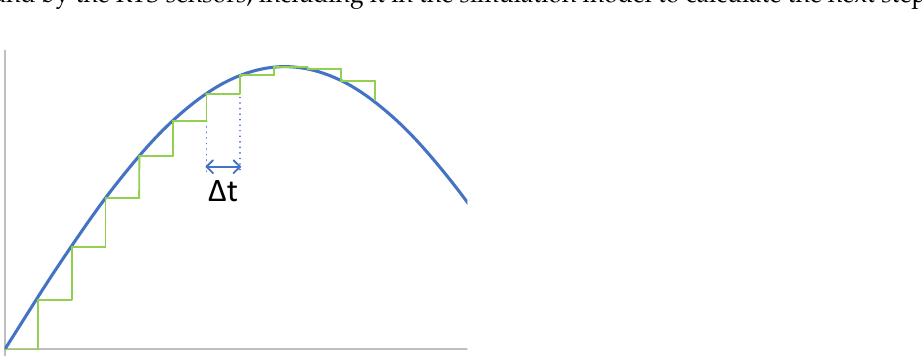
Figure 6. Real-time simulation time step ∆ t (shown in green) for signal (shown in blue), adapted from [57].